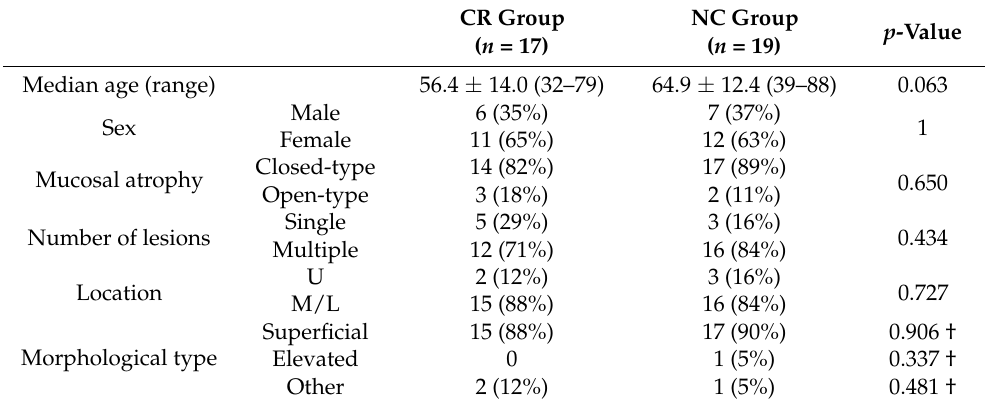
Table 1. Comparison between CR and NC groups in gastric MALT lymphoma negative for both Hp and API2-MALT1 chimeric